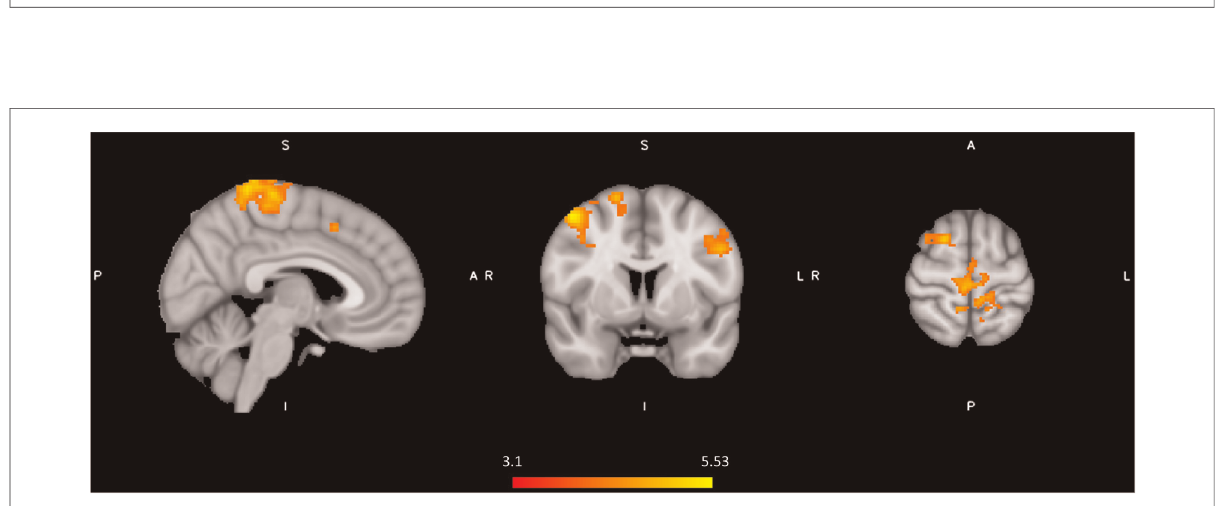
FIGURE 7 Signi fi cant neural responses to thermal noxious stimuli, resulting from a whole-brain analysis of the spinal condition visit fi rst versus the spinal condition visit secondly (Spinal second (post-pre) - Spinal fi rst (post-pre) ). Red clusters correspond to higher BOLD response during spinal anesthesia second visit compared to spinal anesthesia fi rst visit, p < 0.05 cluster corrected. Images are Z-statistics thresholded at (-)3.1, overlaid on the MNI-152 standard brain. A=Anterior, I=Inferior, L=Left, P=posterior, S=Superior, R=Right. The signi fi cant clusters are described in detail in Table 4